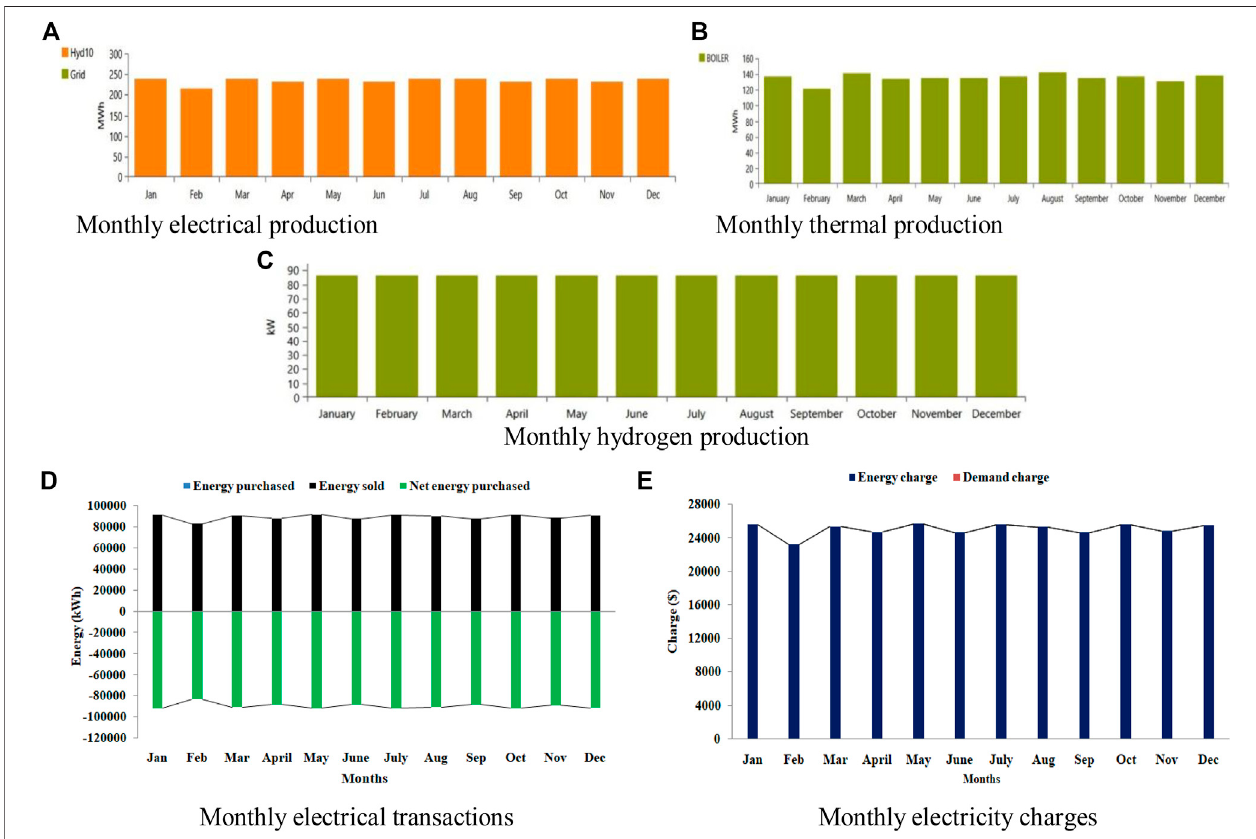
FIGURE 12 | Monthly energy productions, transactions, and charges. (A) Monthly electrical production. (B) Monthly thermal production. (C) Monthly hydrogen production. (D) Monthly electrical transactions. (E) Monthly electricity charges.